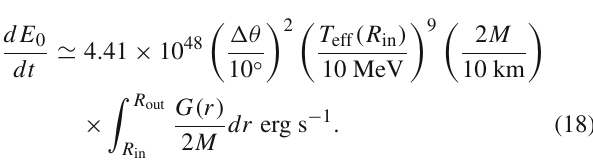
explicit EDR expression is given by [43]